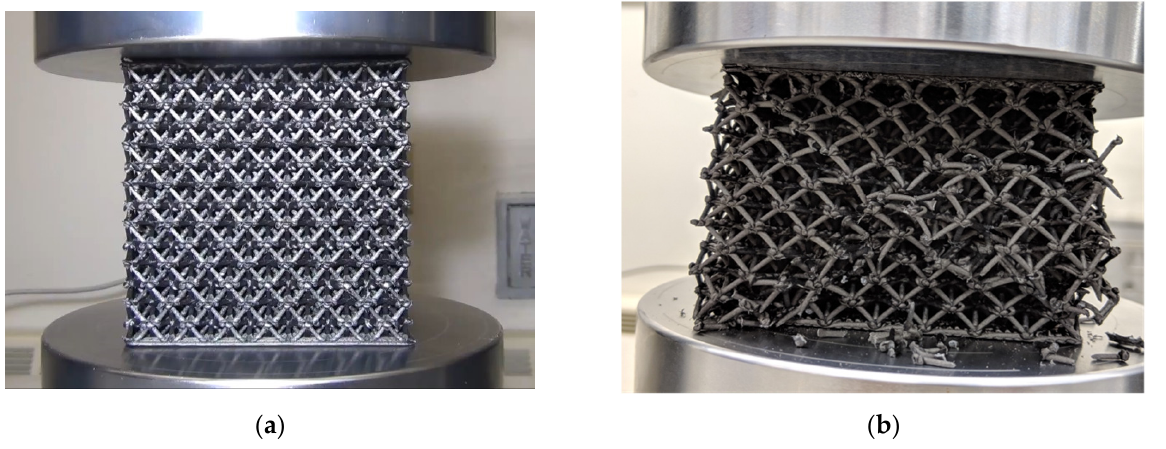
Figure 15. Compression testing of Octet Truss specimens on an MTS universal testing machine ( a ) before compression and ( b ) after compression.